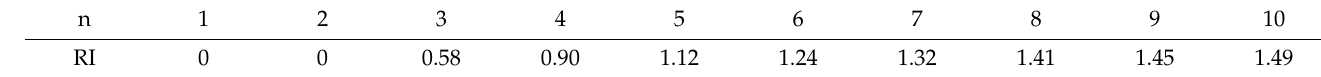
Table 3. Random Index based on the number of criteria.